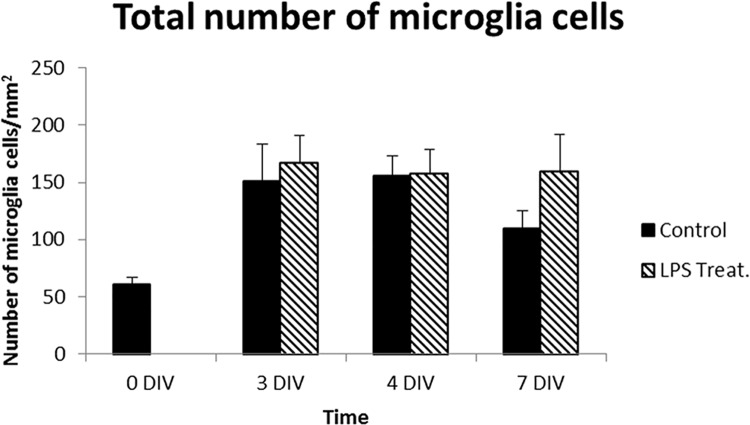
Total numbers of microglia cells.The graph shows quantification of total numbers of Iba1/ED1-positive cells. ANOVA analysis was performed for comparison between the LPS-treated group and the control groups. Data are given as mean ±StDev (n = 3-6/group).